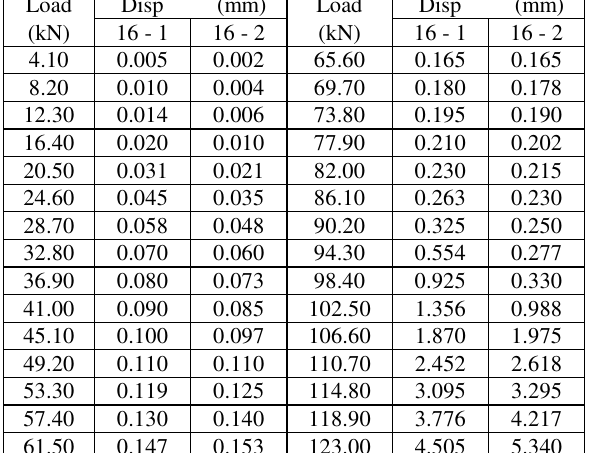
Table 2. Observed Displacements for the 16 mm diameter